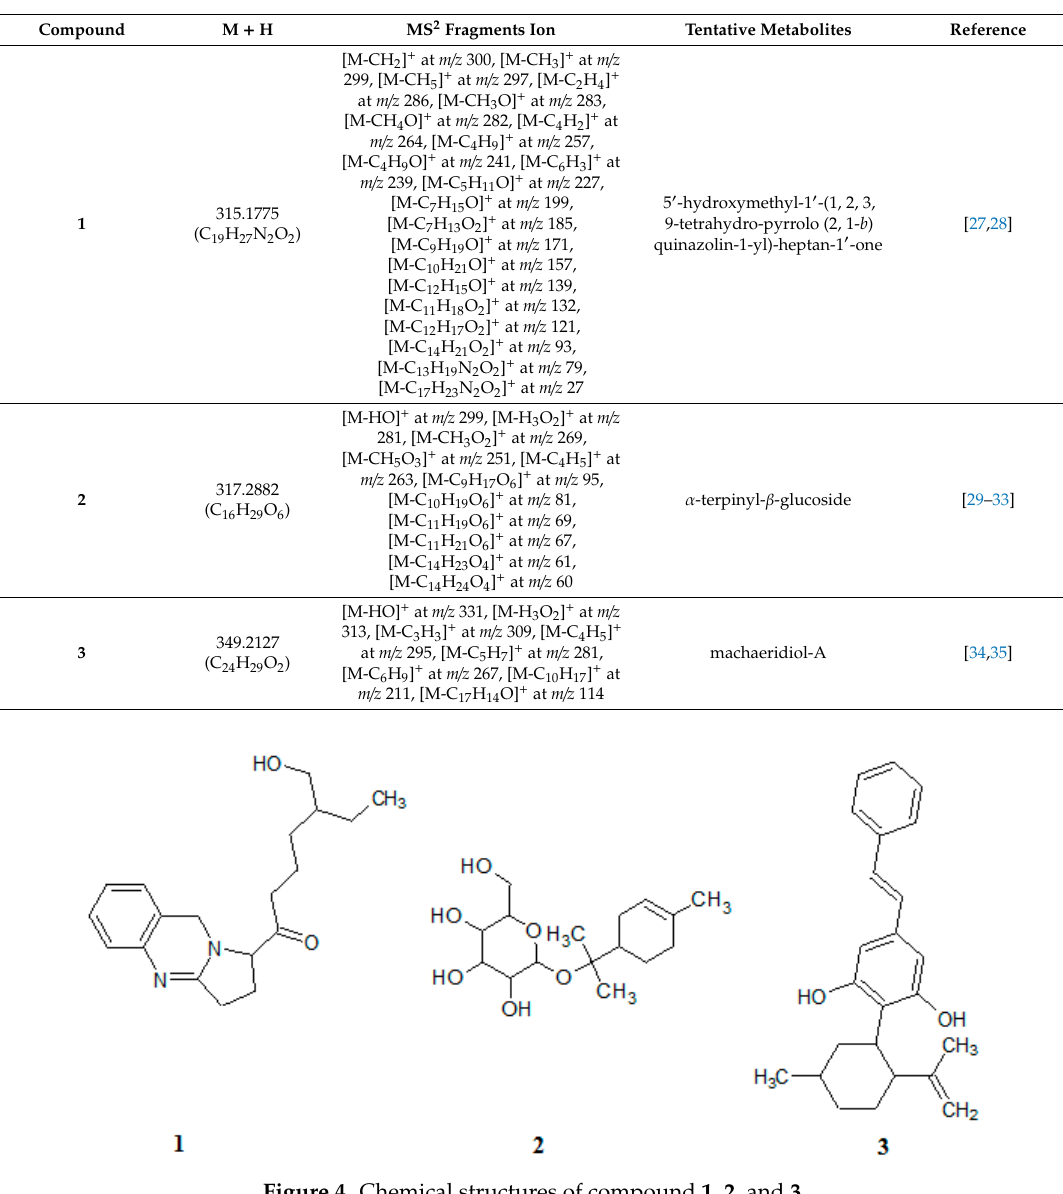
Table 1. Tentative metabolites identified in the P. malayana Jack leaves through LC-MS / MS fragmentation using positive ionization.